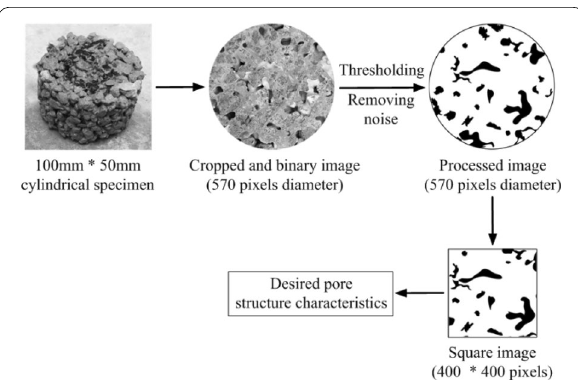
Fig. 4 The schematic of the image analysis method [Referred to Neithalath et al. (2010)].